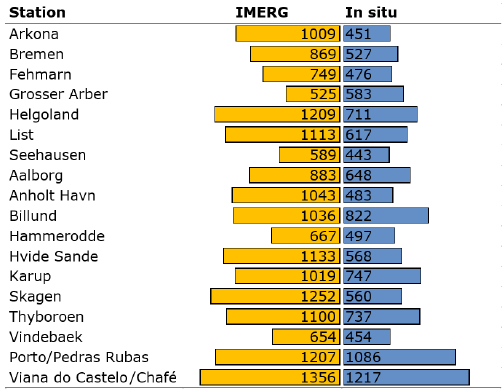
Figure 7. Average annual rainfall (mm) during 2014–2019 from IMERG and in situ observations for the 18 stations